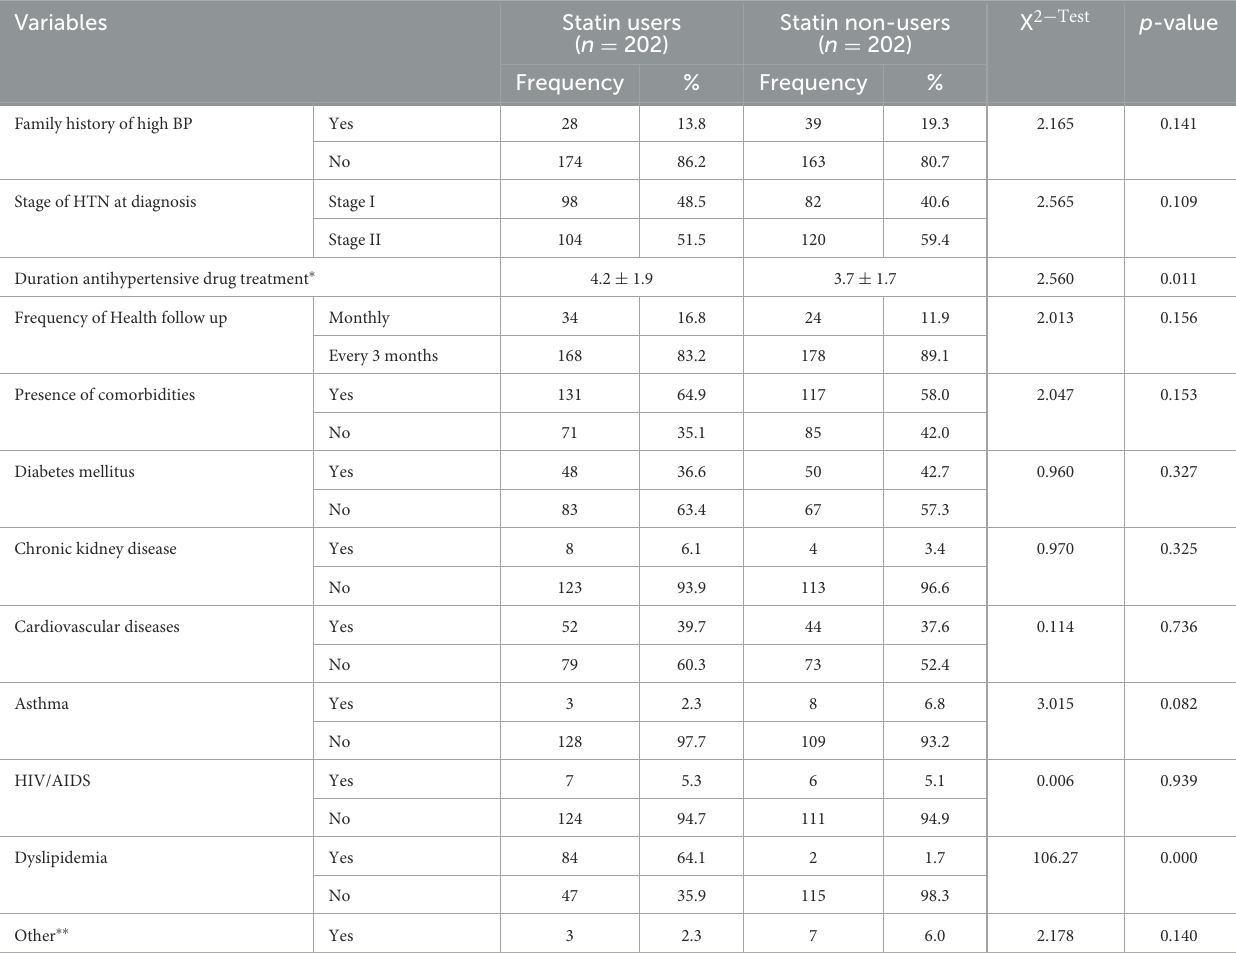
TABLE 3 Clinical features of patients with hypertension attending the outpatient clinic at FHCSH, northwest Ethiopia.